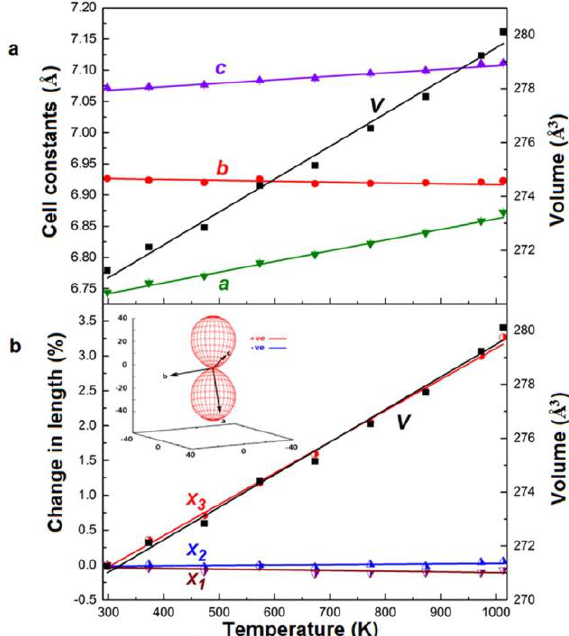
Figure 16. Thermal expansion behavior of the KZnB 3 O 6 . ( a ) The temperature dependence of lattice constants a, b, c and cell volume; ( b ) normalized components of the principal axes versus temperature. Reprinted with permission from Ref. [66], Copyright (2015) Creative Commons Attribution 4.0